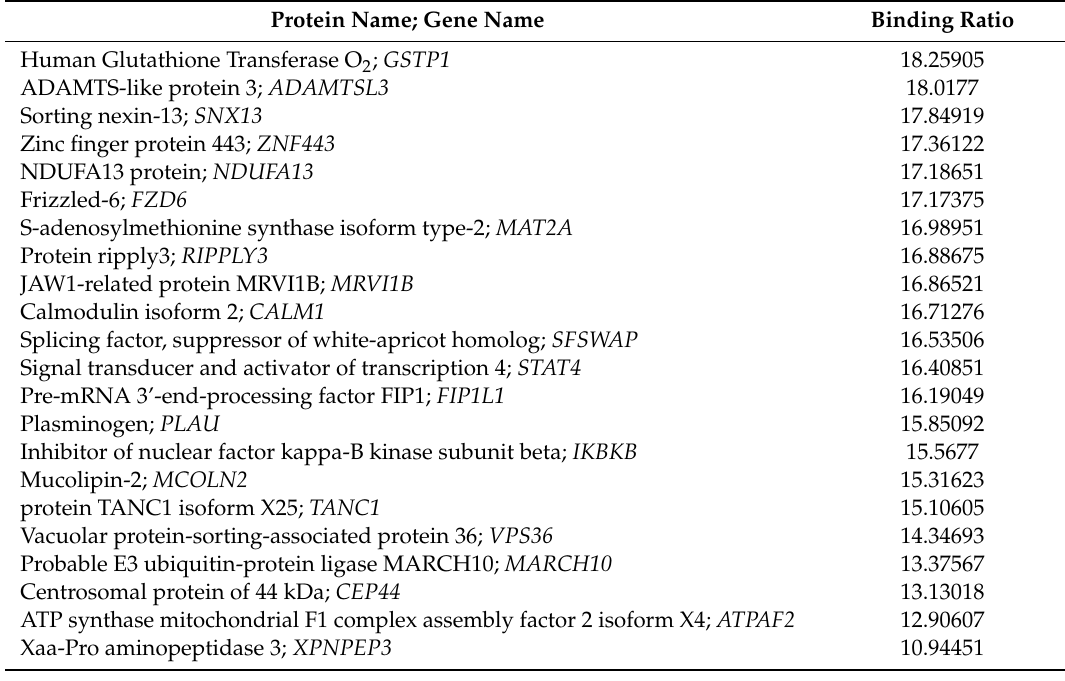
Table 1. Identified proteins from immunoprecipitation reaction of ORF3 transfected cell